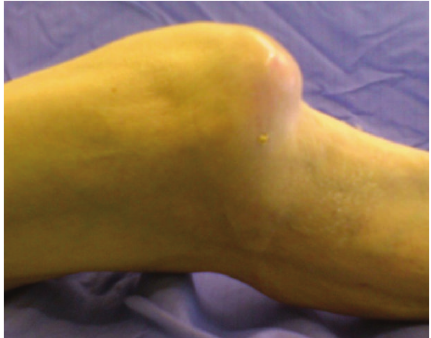
Figure 1: Lateral view of the knee.